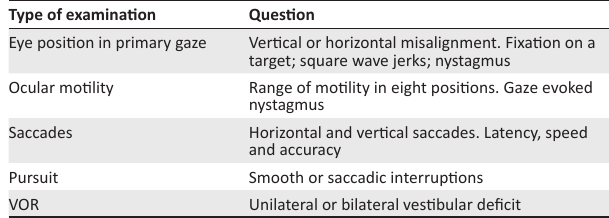
FIGURE 3: Neurological involvement in Niemann-Pick disease type C, with emphasis on type and age of onset of neuropsychiatric signs and symptoms.